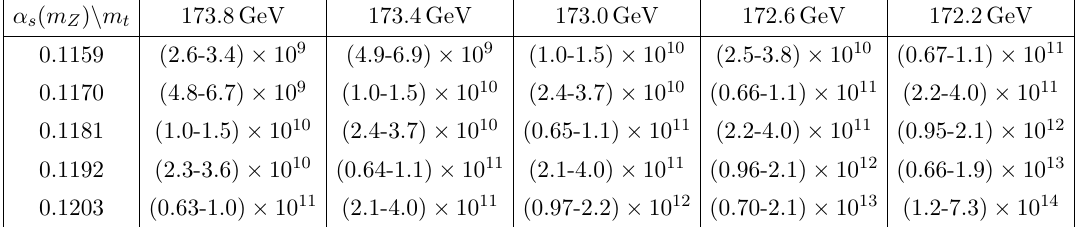
Table 1 . The prediction for v 0 for m h = (125 : 18 (cid:6) 0 : 16)